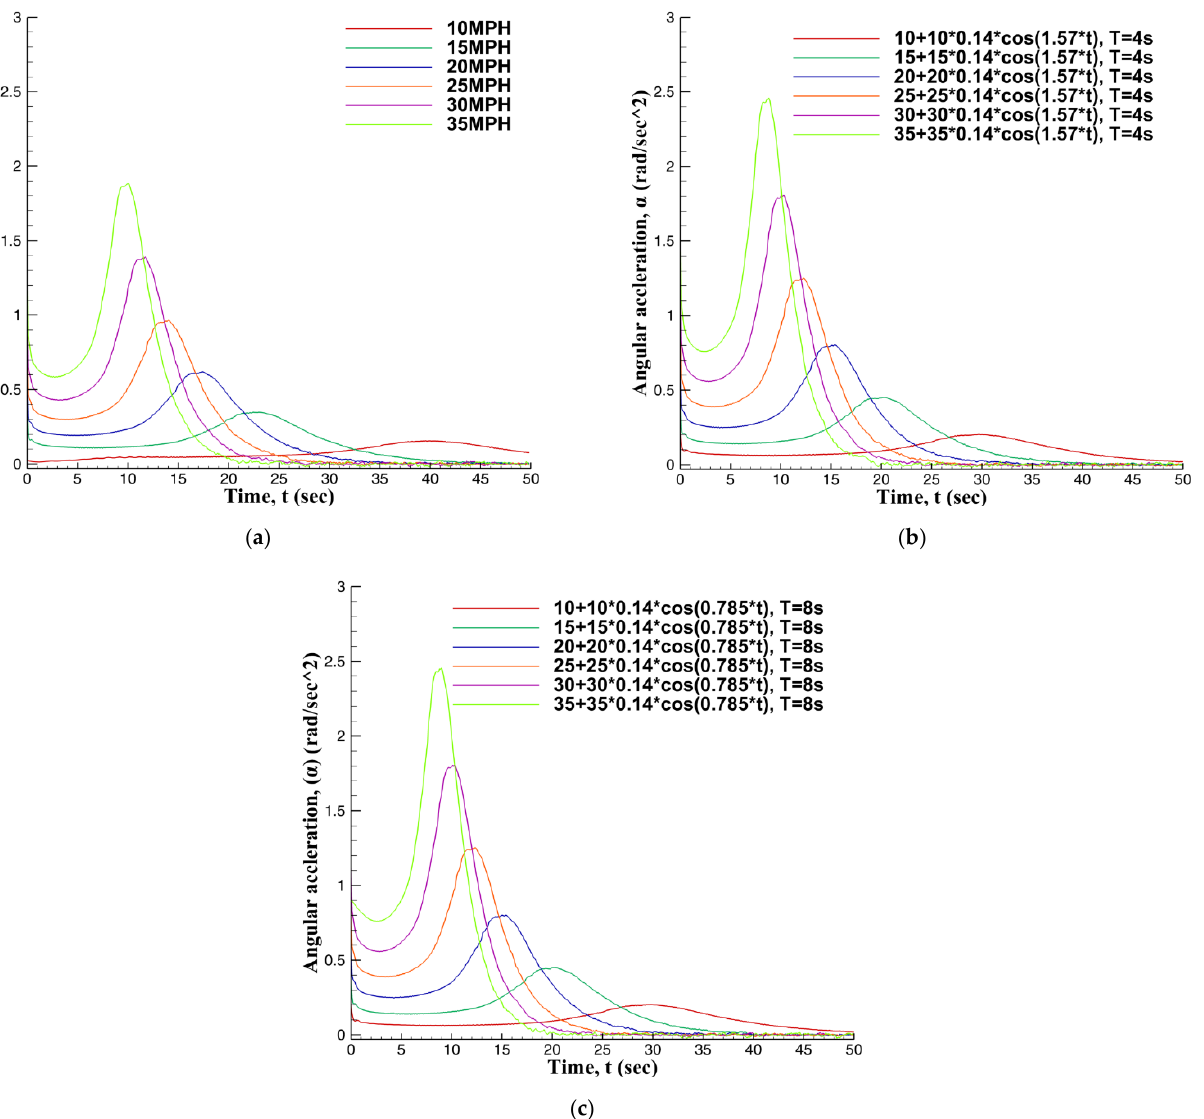
Figure 5. The evolution processes of the angular acceleration of the rotor activated from stationary by the various uniform wind fields. ( a ) Steady wind field; ( b ) periodic wind field, T = 4 s; ( c ) periodic wind field, T = 8 s.